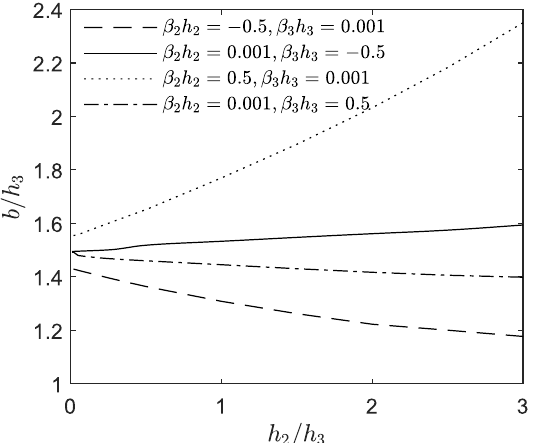
Figure 10. The dependence of the non–dimensionalized receding contact half–length on the thickness ratio h 2 / h 3 for different inhomogeneity parameters β 2 h 2 and β 3 h 3 ( µ 03 = µ 1 , a / h 3 = 0.5 )